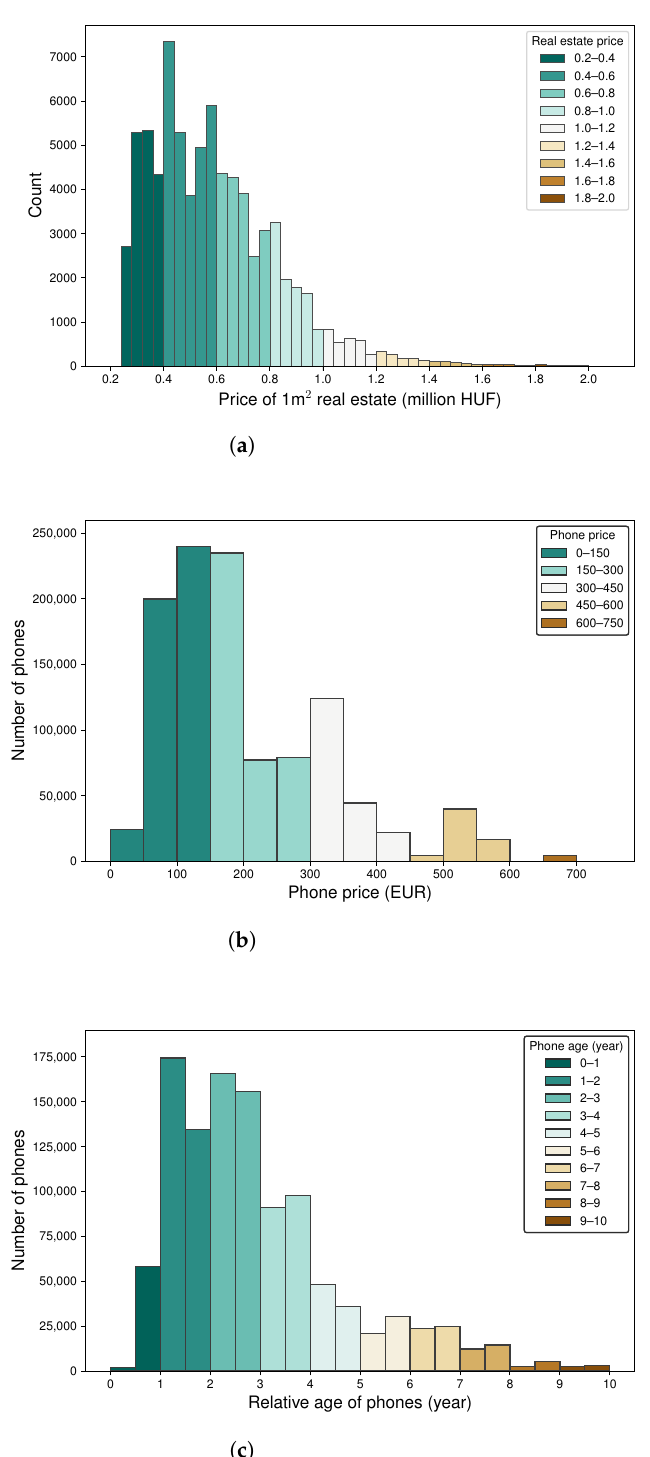
Figure 6. Distribution of the real property prices ( a ), the mobile phone prices ( b ), and the mobile phone relative ages ( c